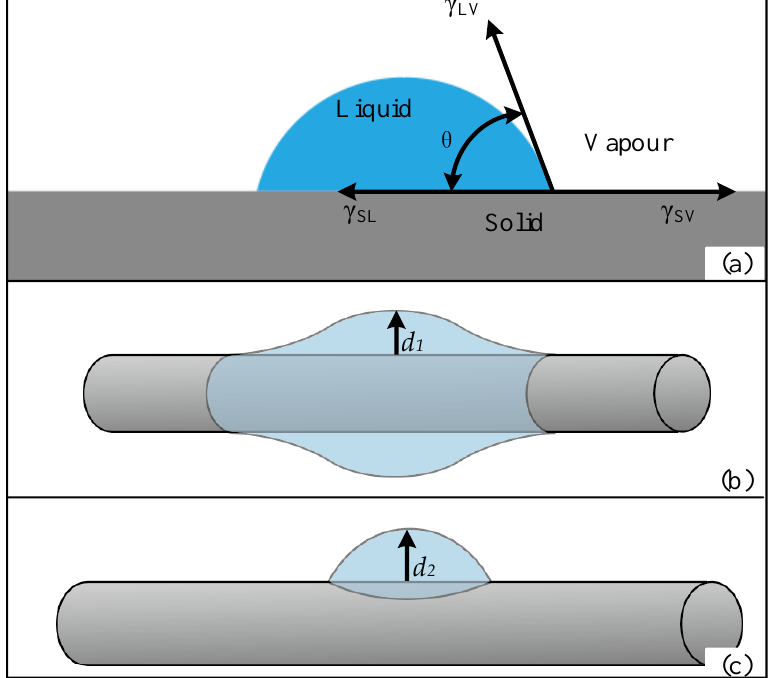
Figure 8. Contact angle. ( a ) The droplet formed on the solid plane and its contact angle θ. The two equilibrium states of the droplets formed on the surface of the cylinder are ( b ) barrel-type and ( c ) clam-shell. The droplets formed on the cylinder surface at heights d 1 and d 2 , respectively.